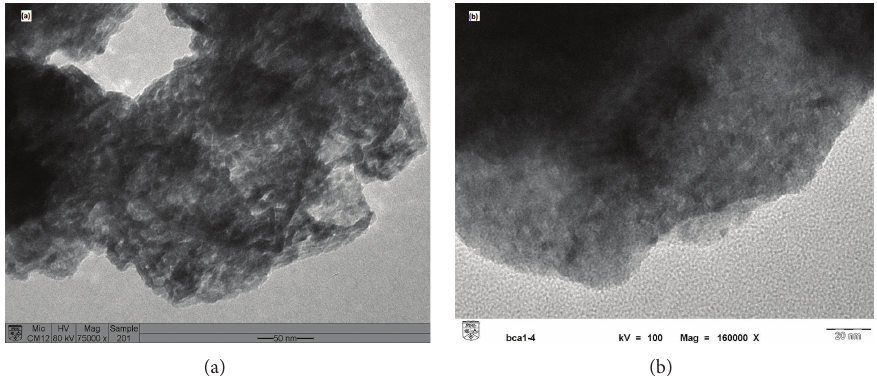
Figure 11: TEM images of (a) CaO and (b) Al 2 O 3 ⋅ CaO nanocatalysts fabricated with surfactant (SDS).